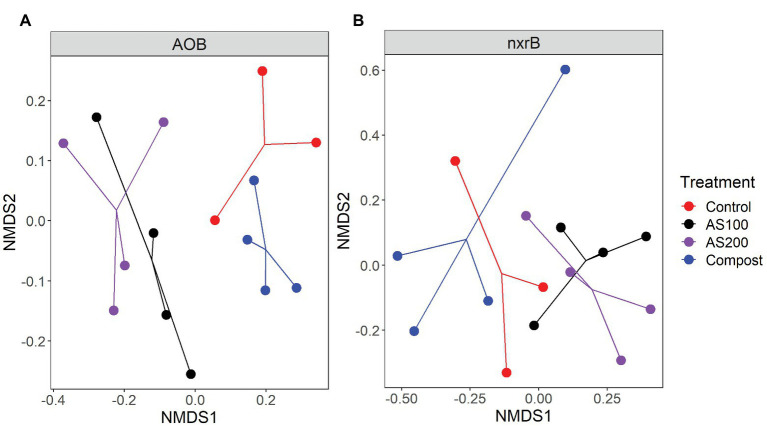
NNMDS ordination based on the Bray-Curtis distance matrices showing the change in AOB (A) and Nitrospira
(B) community composition for four N treatments.